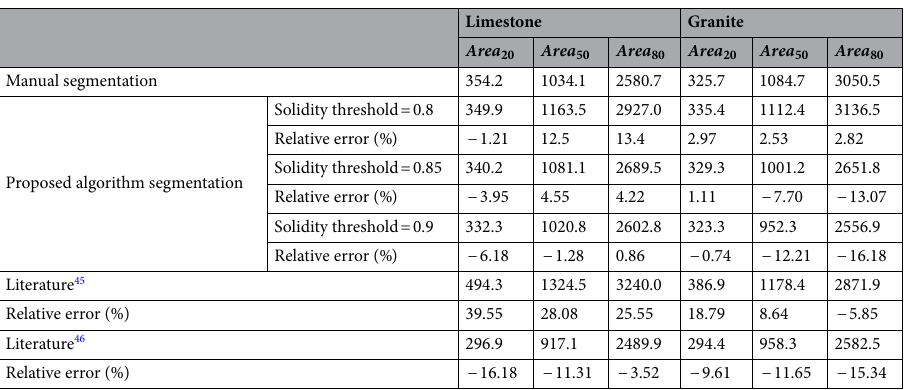
Table 3. Three characteristic area